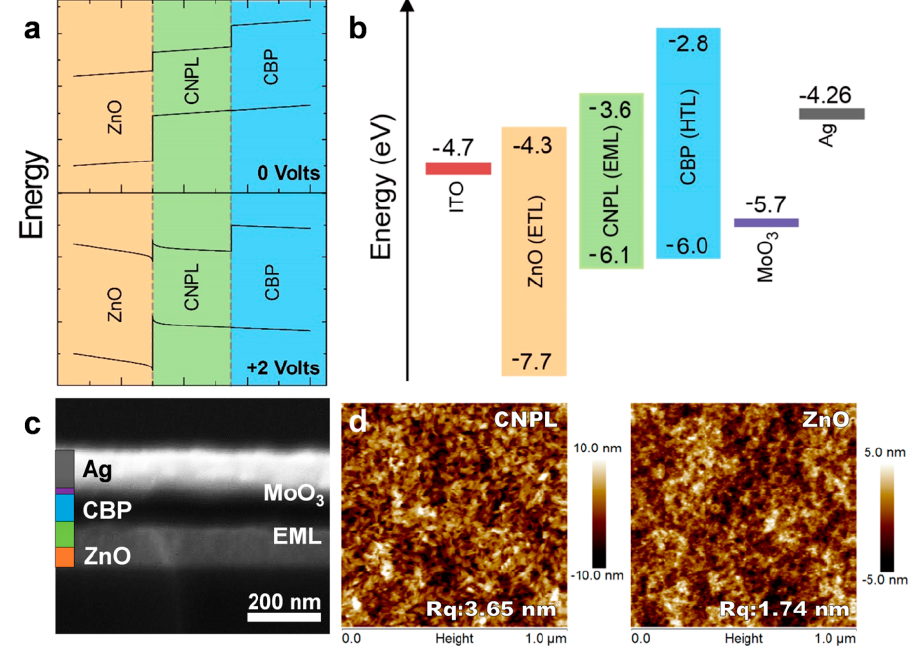
Figure 4. ( a ) The NPL-LED under zero-bias and forward bias near turn-on voltage (2 V), modeled using SCAPS; ( b ) The energy levels for NPL-LEDs; ( c ) Cross-sectional SEM image of the NPL-LED; ( d ) Left: AFM for NPLs which have been spin-coated above ZnO (the surface roughness is 3.56 nm). Right: AFM for only ZnO (the surface roughness is 1.74 nm). Adapted from [36], with permission from © 2015 American Chemical Society.